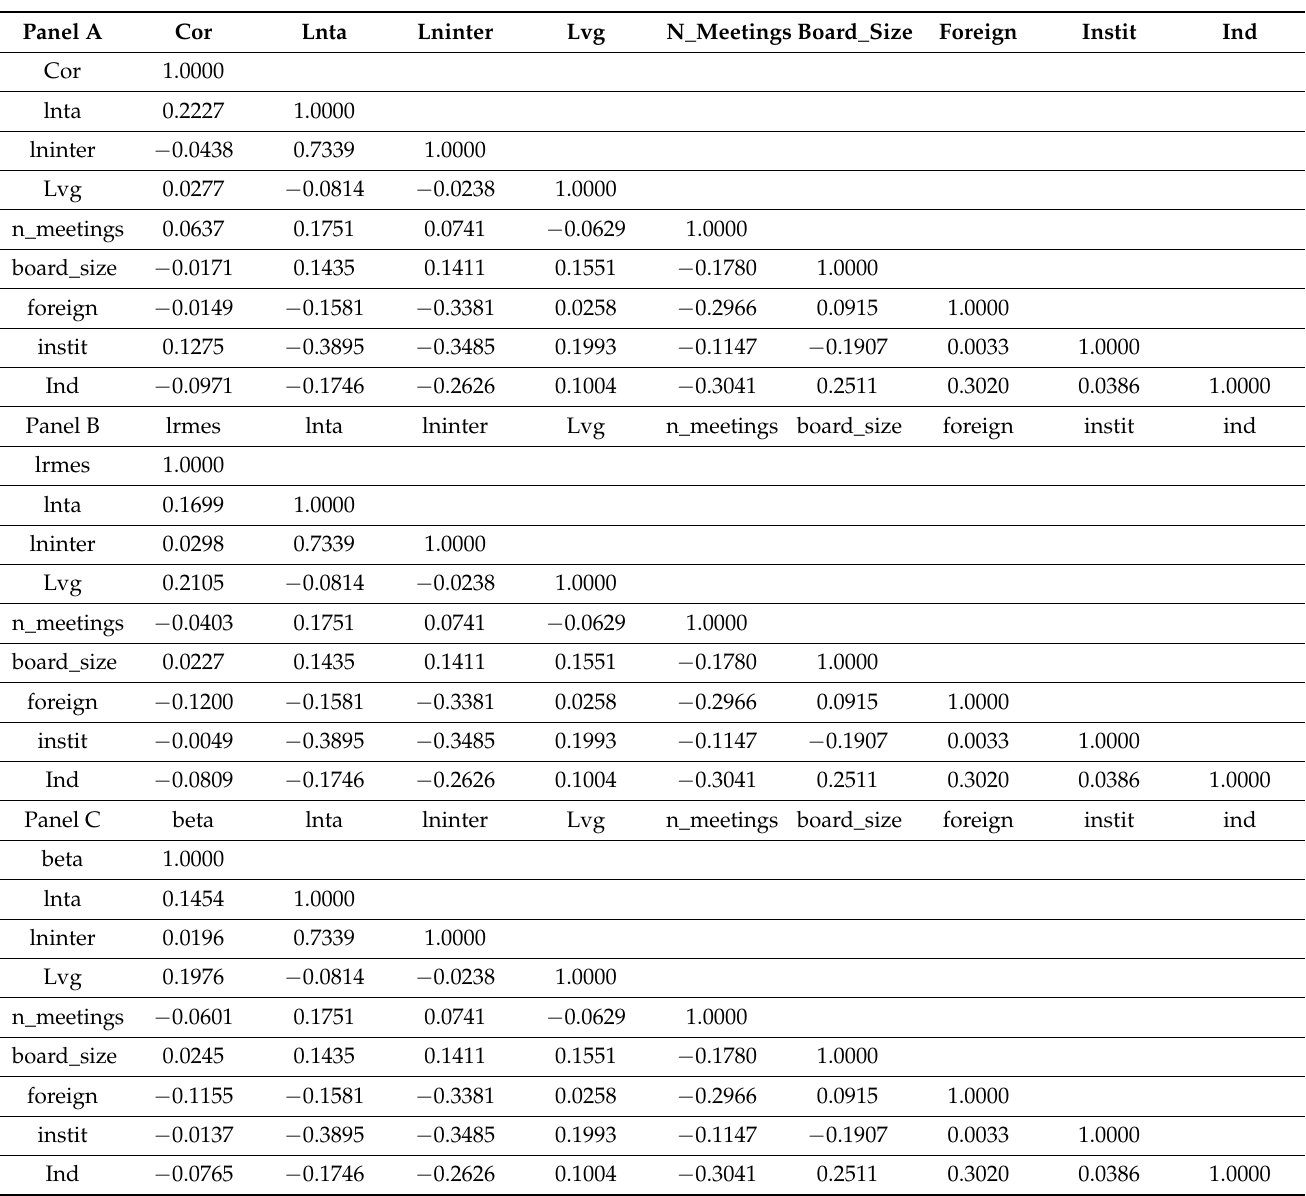
Table 4. Pearson correlation matrix of the independent